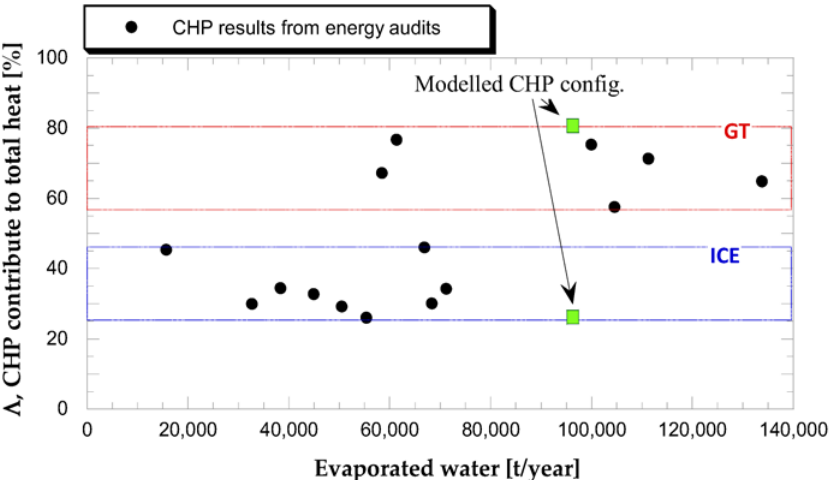
Figure 6. Percentage contribution of CHP thermal energy to total heat required by drying process as function of annual evaporated water. CHP results from energy audits [13].